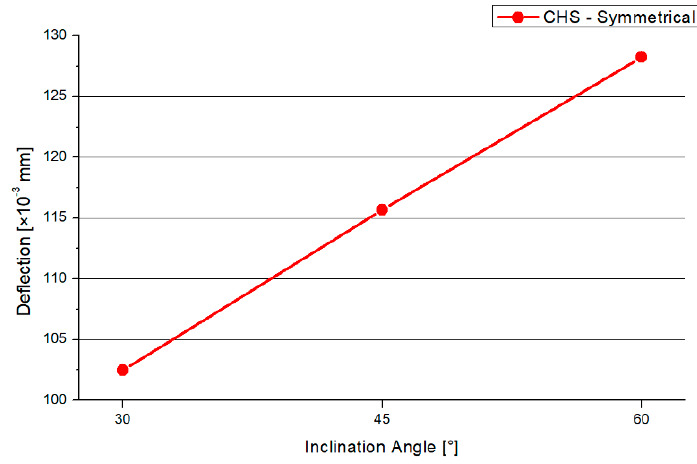
Figure 6. Deflection CHS Symmetrical.